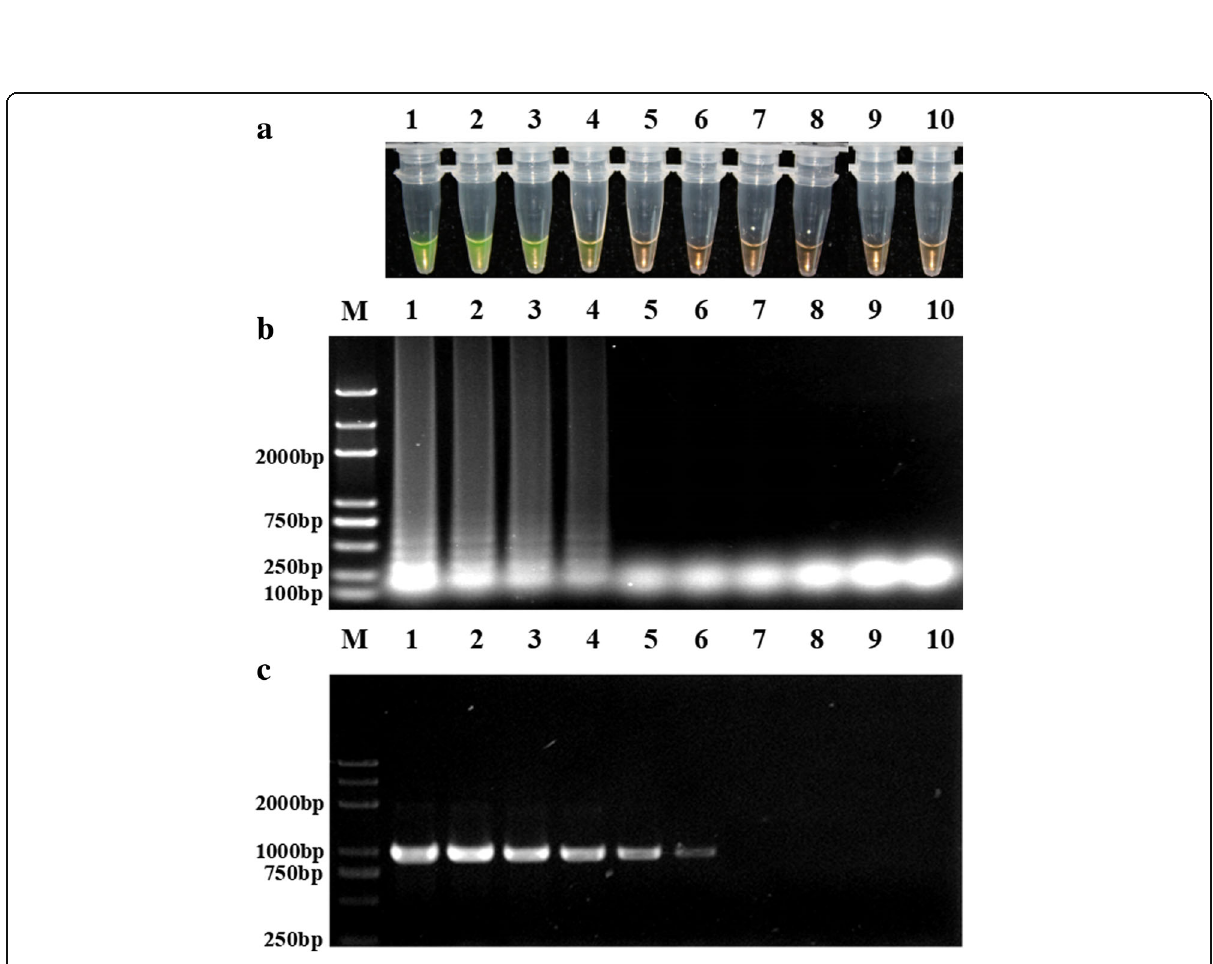
Fig. 3 Sensitivity comparison of LAMP and conventional PCR for the detection of the E198V mutation using plasmid pMD18-TubA . a LAMP products detected with 1000 × SYBR Green I. b LAMP assessment based on agarose gel electrophoresis. c Conventional PCR assessment based on agarose gel electrophoresis. Lane M: DNA 2 K plus Marker; tubes and lanes 1 – 9: concentration of plasmid pMD18-TubA at 2 × 10 8 , 2 × 10 7 , 2 × 10 6 , 2 × 10 5 , 2 × 10 4 , 2 × 10 3 , 2 × 10 2 , 2 × 10 1 , and 2 × 10 0 copies/ μ L, respectively; tube and lane 10: ddH 2